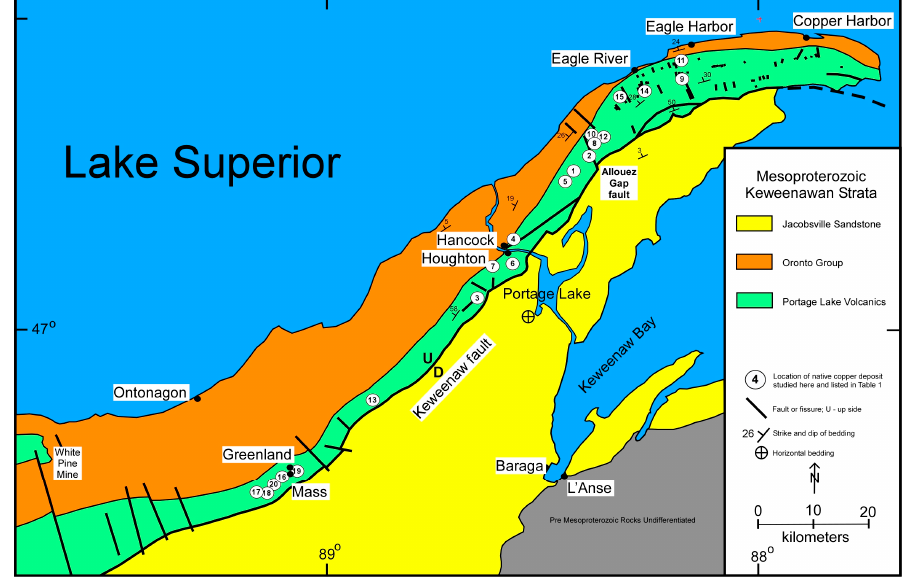
Figure 2. Bedrock geologic map of the Keweenaw Peninsula in the western part of the Upper Peninsula of Michigan. Numbered locations of native copper deposits correspond to Table 1. The main part of the Keweenaw Peninsula native copper district extends from approximately deposit 3 to 12. A concentration of small native copper deposits is located in the Greenland-Mass subdistrict.